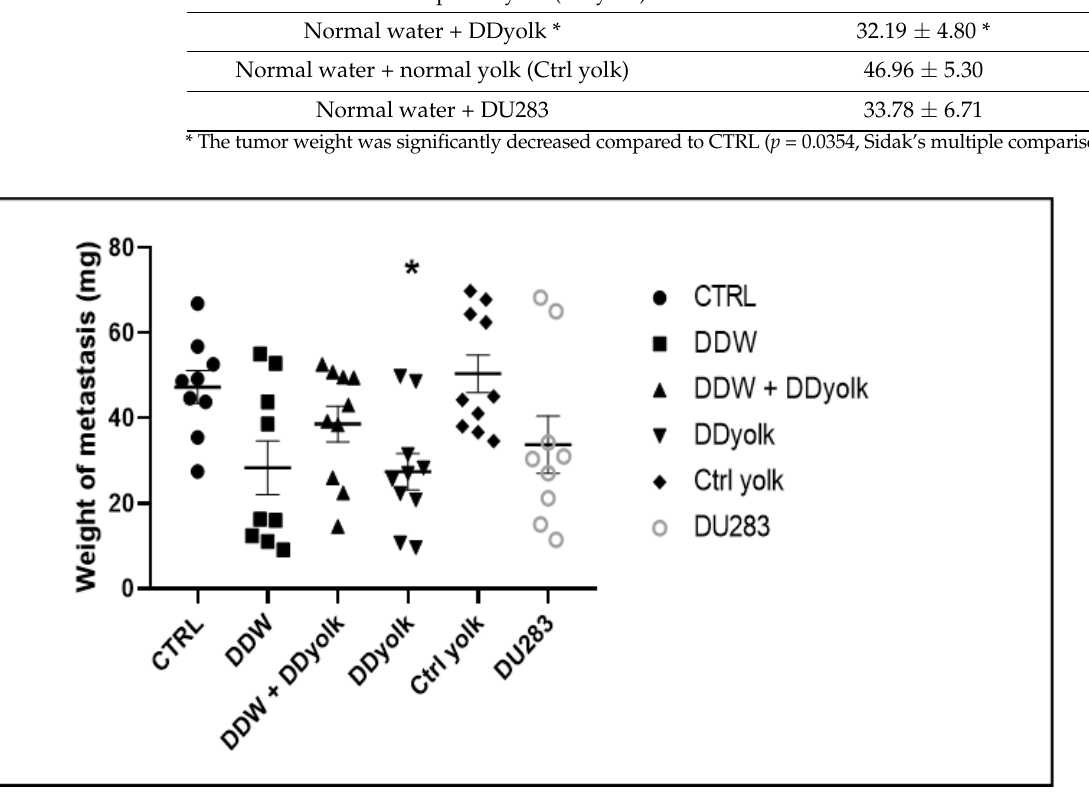
Table 3. Average weight of the metastases in the formalin fixed lungs in the control and treated groups. Weight of the Metastasis Treatment (Milligrams; mean ± SEM, n = 10)) Normal water (CTRL) 45.20 ± 4.02